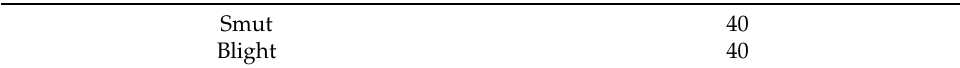
Table 1. Original